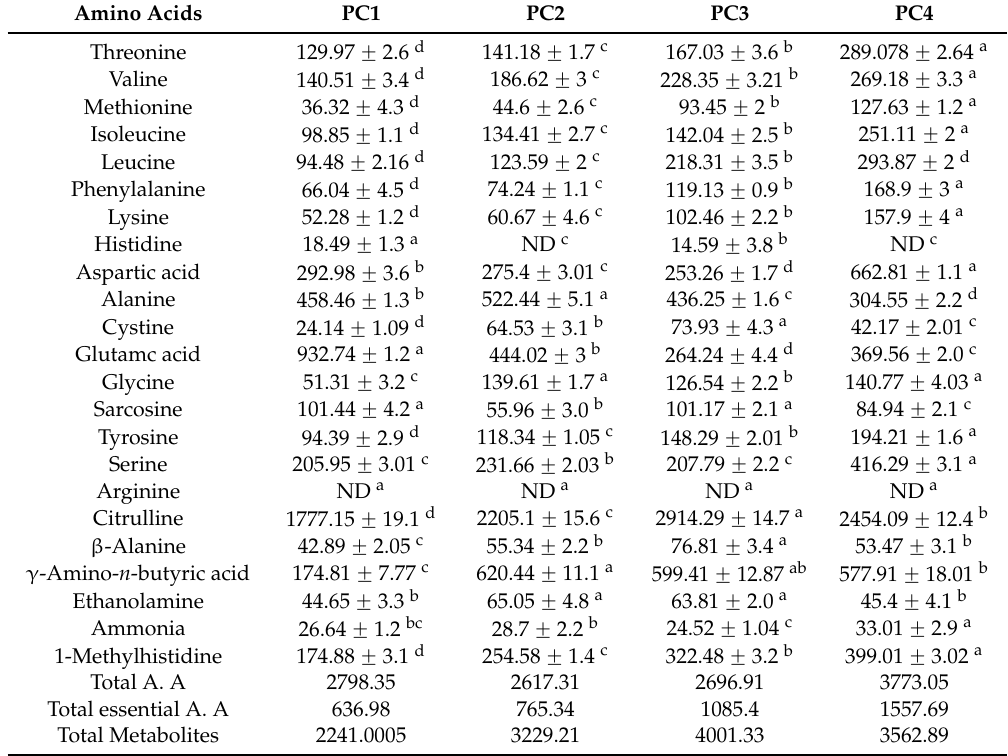
Table 3. Amino acid analysis of the four different cultivars of persimmon